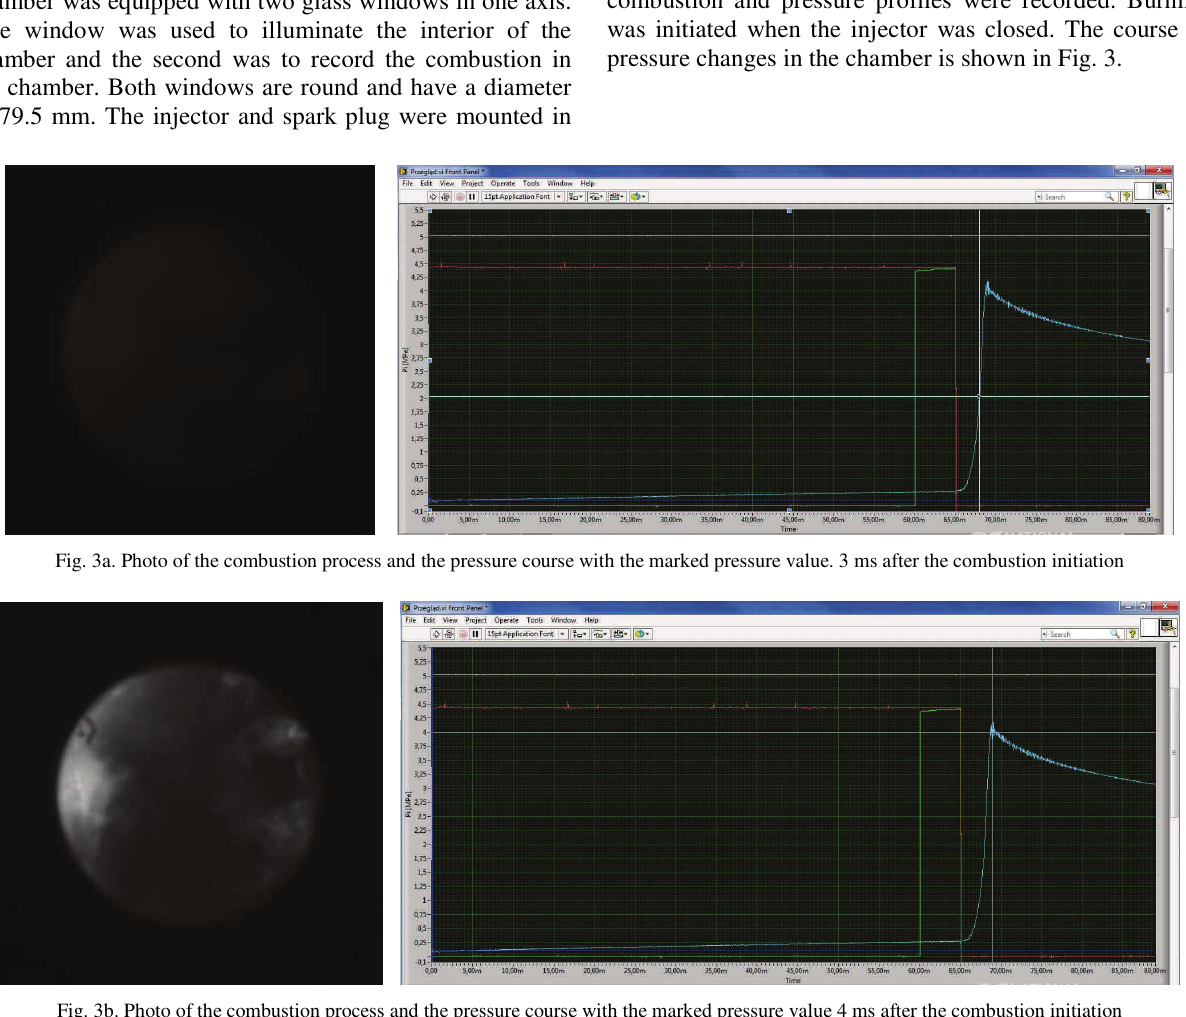
Fig. 3b. Photo of the combustion process and the pressure course with the marked pressure value 4 ms after the combustion